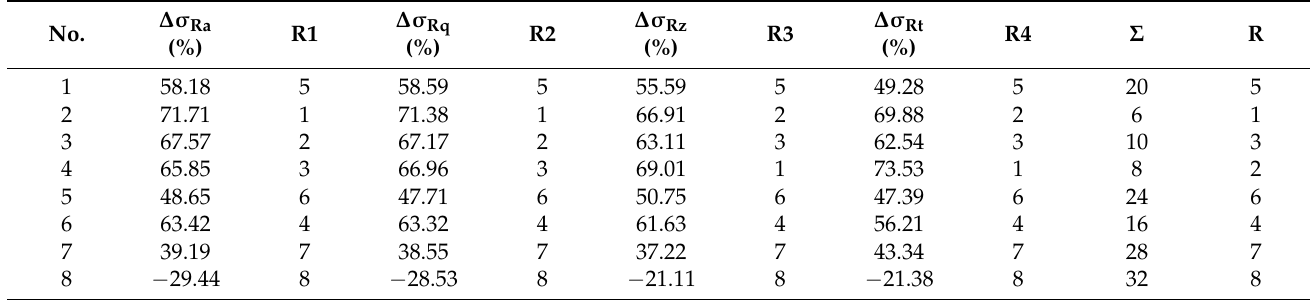
Table 9. Ranking of results for Experiment